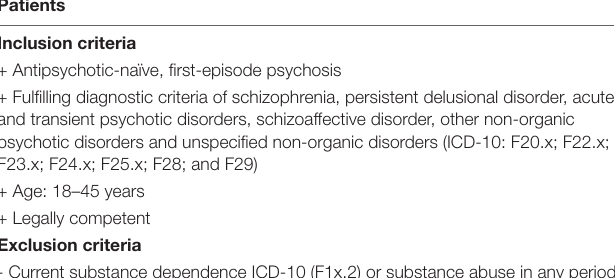
TABLE 1 | In- and exclusion criteria in AMEND.